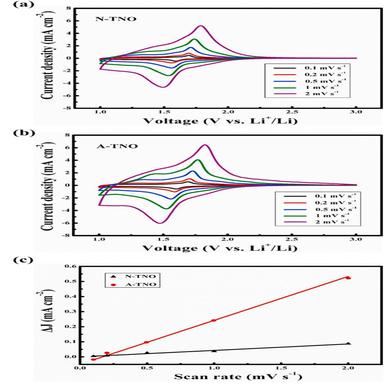
Cyclic voltammograms of TiNb2O7 samples synthesized via (a) the solidstate method and (b) the agar-assisted method at different scan rates from 0.1 to 2 mV s − 1 . (c) Scan rate dependence of the current densities of TiNb2O7 samples synthesized via both the solid-state method and the agar-assisted method.